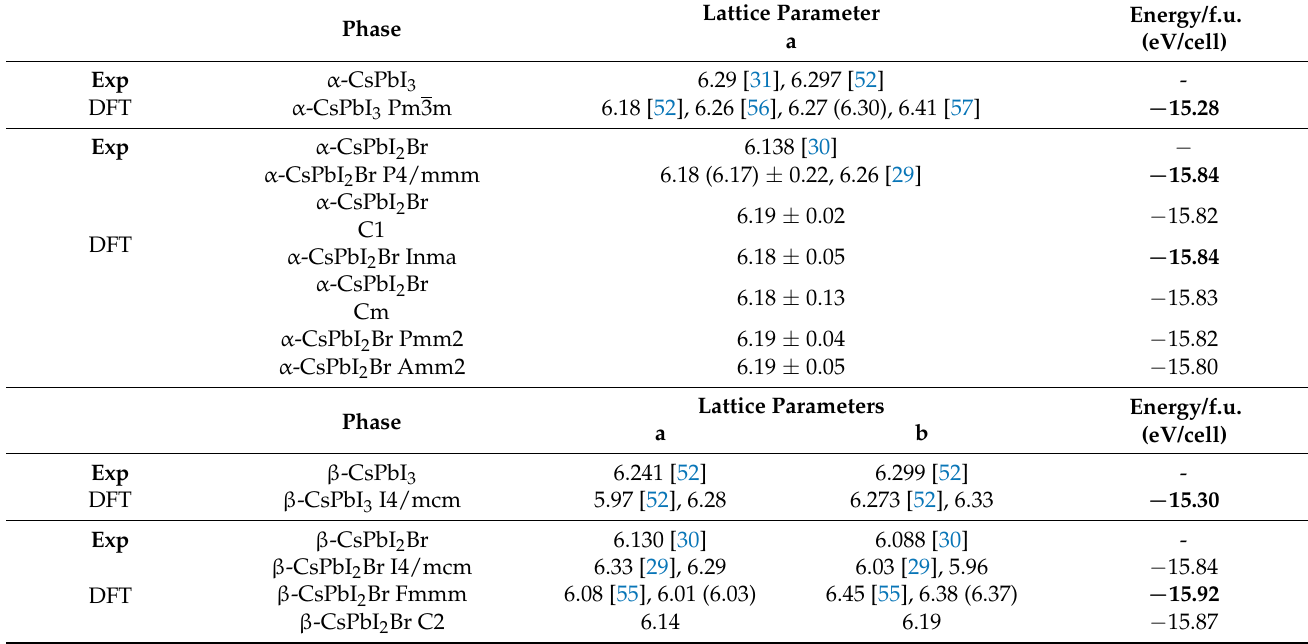
Table 1. Normalized lattice constants (Å) of various experimentally measured and theoretically simulated α -CsPbI3 β -CsPbI3, α -CsPbI2Br and β -CsPbI2Br phases. Values obtained in this work are in italics, values inside of round parentheses were computed with spin–orbit coupling included. Note that for α phases, only the a lattice parameter is represented while for β phases, the a and b parameters are